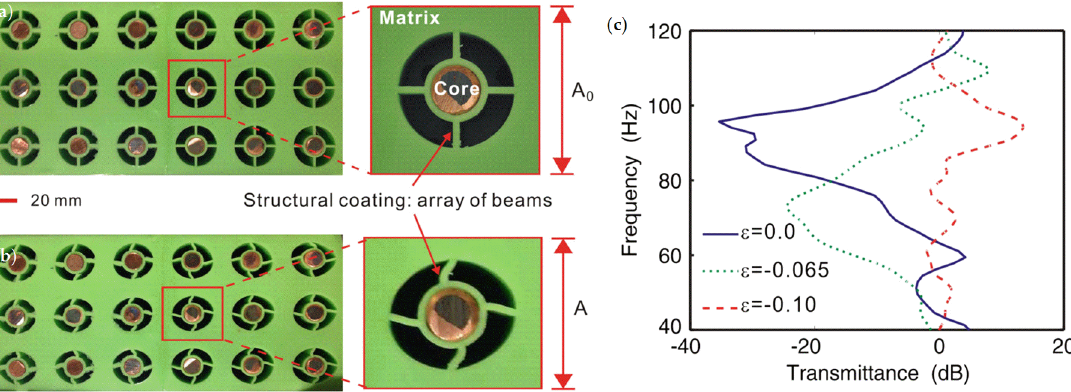
Figure 6. Tunable acoustic metamaterial: ( a ) Undeformed configuration comprises resonating units dispersed into an elastomeric matrix; ( b ) Deformation of the structure with a compressive strain in the vertical direction; ( c ) Experimental transmittance of the sample with different prestrains. Adapted with permission from [144], APS, 2014.